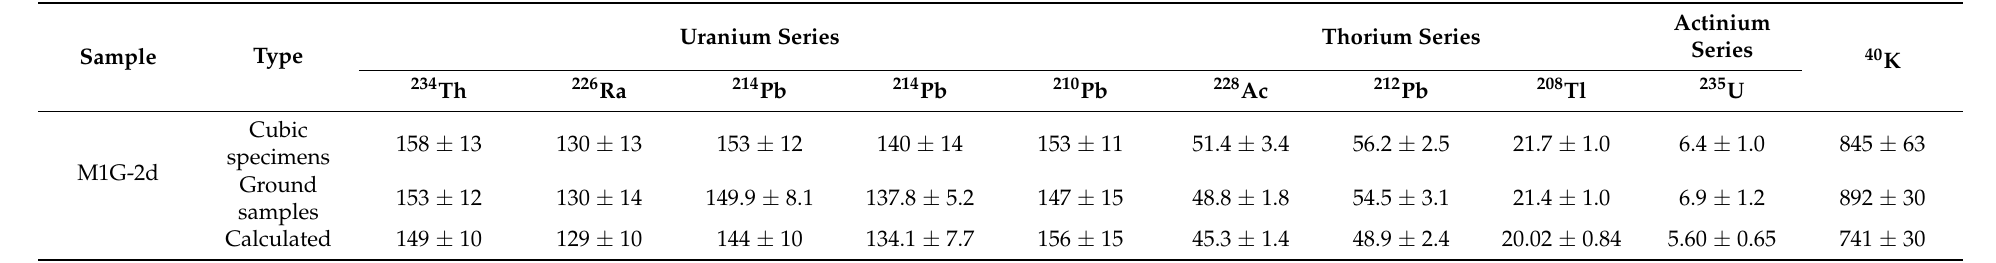
Table 11. Activity concentrations (Bq kg − 1 ) for: (a) hardened hybrid cement 5-cm cubic specimens; (b) ground mortars; and (c) values calculated from the percentage of individual components used to prepare mortars with granite